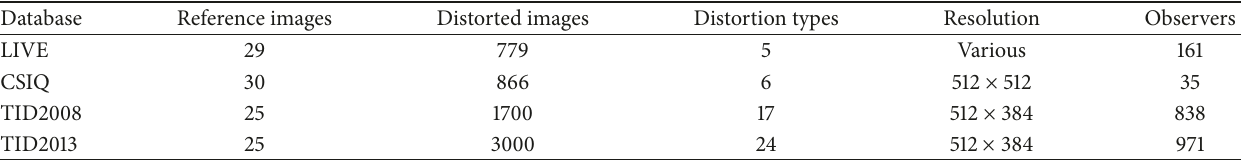
Table 1: Basic information of four databases.